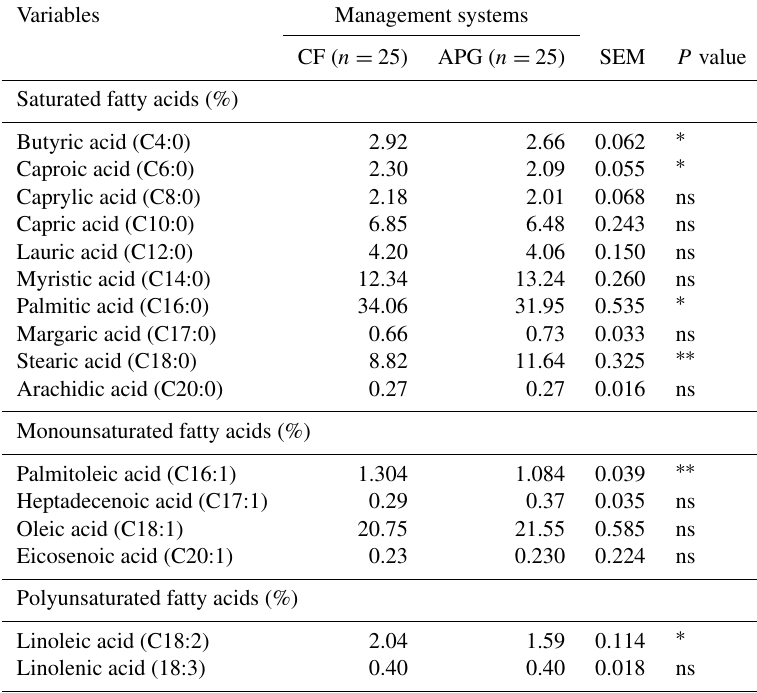
Table 3. Fatty acid composition of the Awassi ewes in the CF and APG management systems.